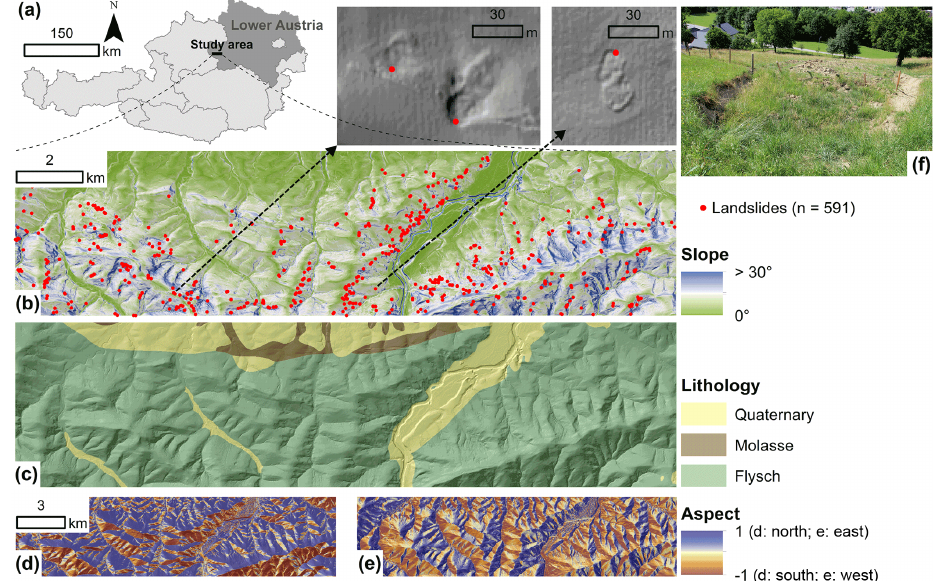
Figure 1. Location of the study area within Austria (a) , shaded relief image of the area with an overlaid slope angle map and spatial distribution of landslide scarps (b) . The shaded relief images (top right) show typical landslides of the study area and the corresponding mapping location. Lithological units are given in (c) while slope orientation is represented as northness (d) and eastness (e) . The photograph (source: K. Gokesch) in (f) relates to the northern part of Waidhofen an der Ybbs and shows a characteristic shallow landslide of the Flysch